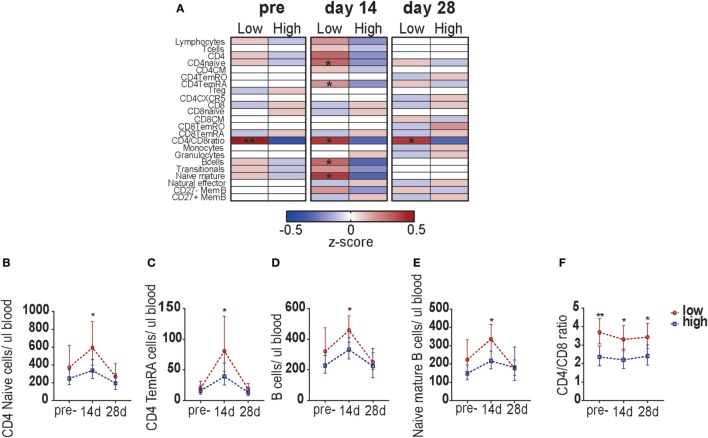
Comparison of leukocyte subset kinetics between adults with low or high pre-cell-mediated immunity (CMI). (A) Comparison of the whole blood absolute immune cell numbers between participants with low and high pre-CMI at the pre- as well as 14 and 28 days post-vaccination time points. The absolute cell numbers were normalized to z-scores, using the geometric means of the low and high group, respectively. z-Scores ranged from −0.5 to 0.5. The normalized z-scores are displayed on a color scale, ranging from blue (geometric means below the geometric mean of the total group) to red (geometric means above the geometric mean of the total group). The white color indicates values equal to the group geometric mean. The stronger the deviation from the group geometric mean, the darker the color. Comparison of the CD4 naïve cells (B), CD4 TemRA cells (C), B-cells (D), naïve B-cells (E), and the CD4/CD8 ratio (F) TruCOUNT kinetics between the participants with low or high pre-vaccination CMI. The groups were compared per subset with the Mann–Whitney U test. *p < 0.05 and **p < 0.01.